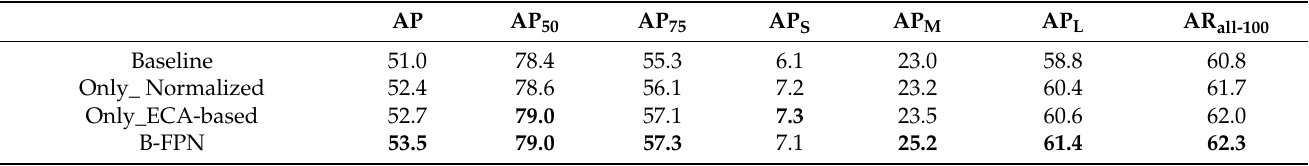
Table 3. B-FPN ablation experiments.